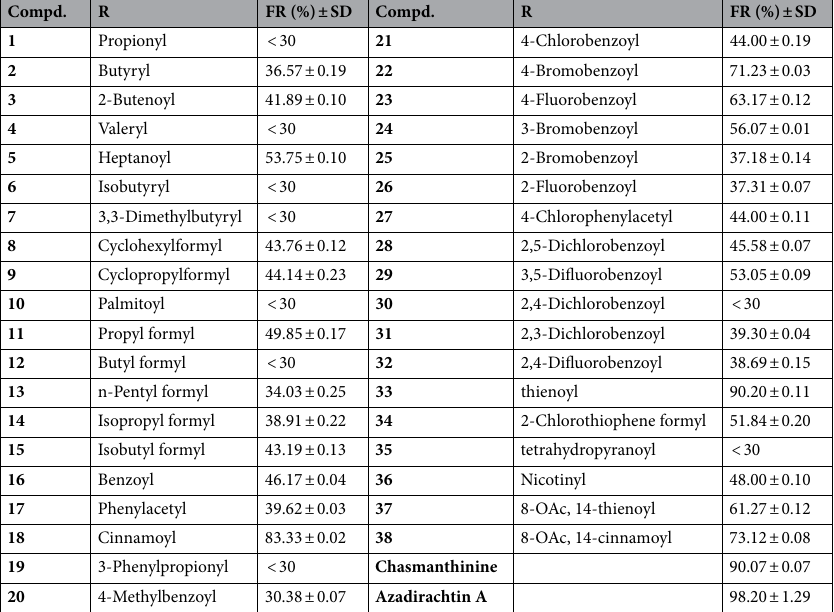
Table 1. The refusal rate (FR) of target compounds against S. exigua at 0.50 mg/mL. The experiments were repeated three times.